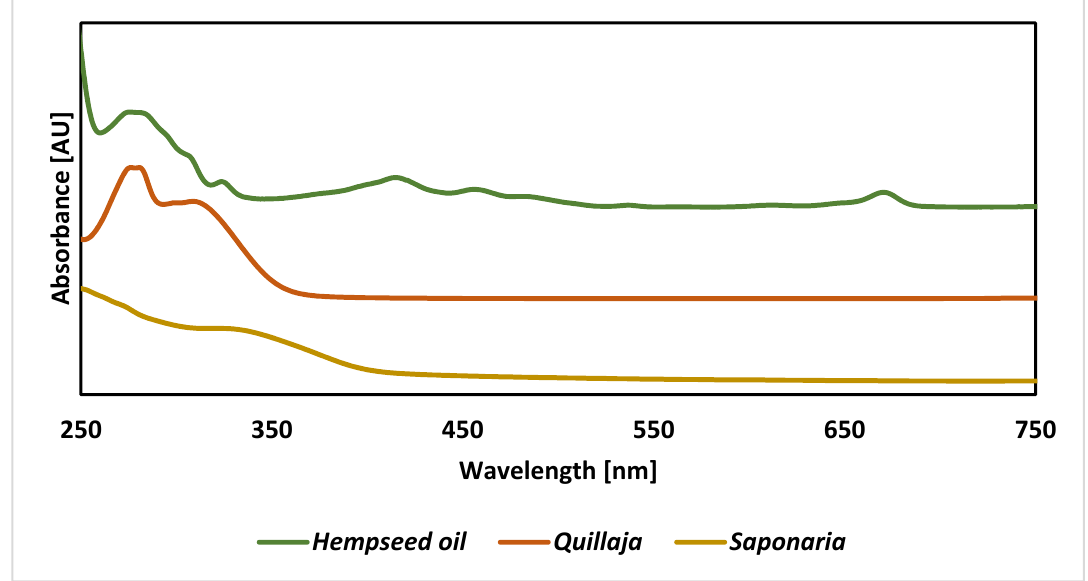
Figure 1. UV-Vis spectra of hempseed oil and 2 g/L water solutions of plant extracts from Saponaria officinalis and Quillaja saponaria .